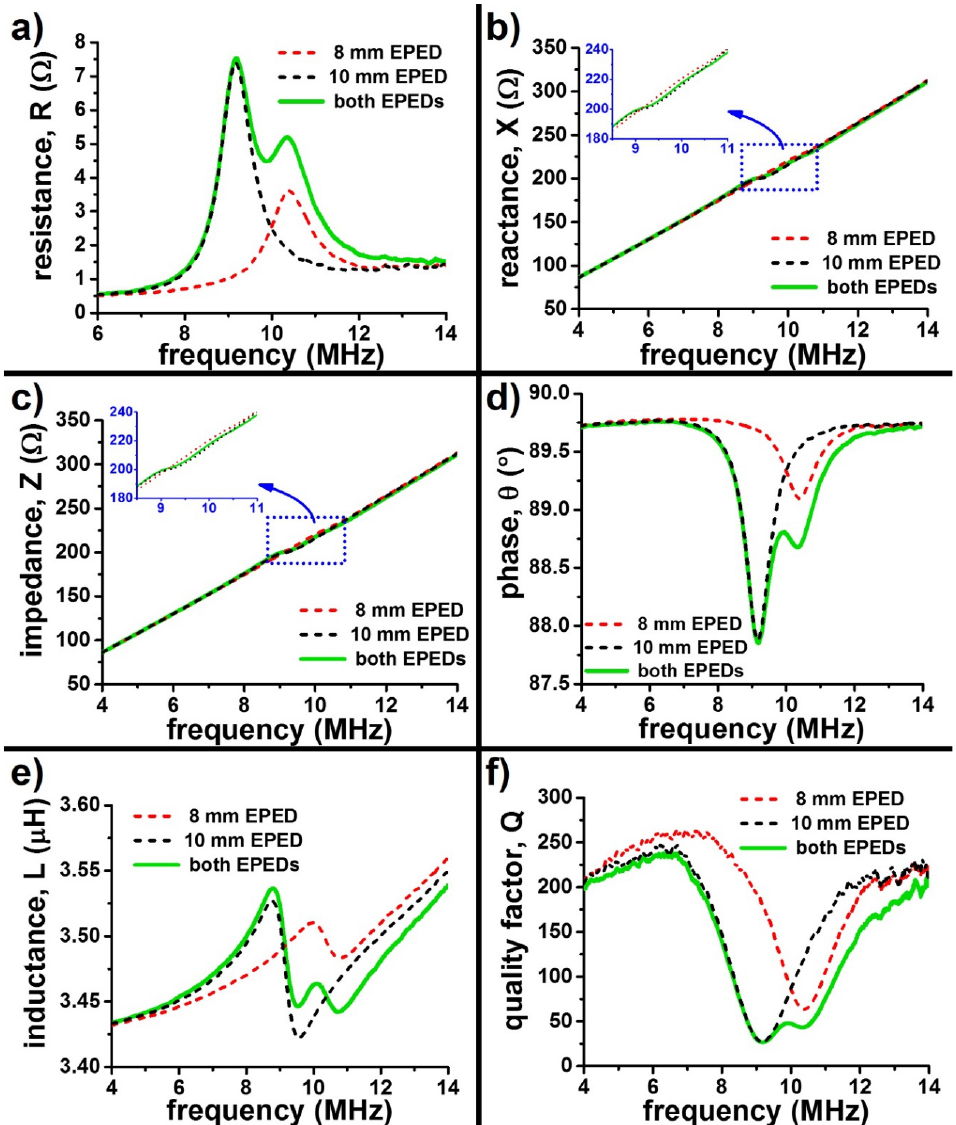
Figure 7. Selective powering of multiple EPEDs by varying excitation frequency, using the same primary coil. The green solid curves in all panels correspond to the frequency dependent passive characteristics when both EPEDs (8 mm and 10 mm side) are 15 cm away from the primary coil. The dashed lines represent individual characteristics: ( a ) Resistance, R; ( b ) Reactance, X; ( c ) Impedance, Z; ( d ) Phase, θ; ( e ) Inductance, L; ( f ) Quality factor, Q.